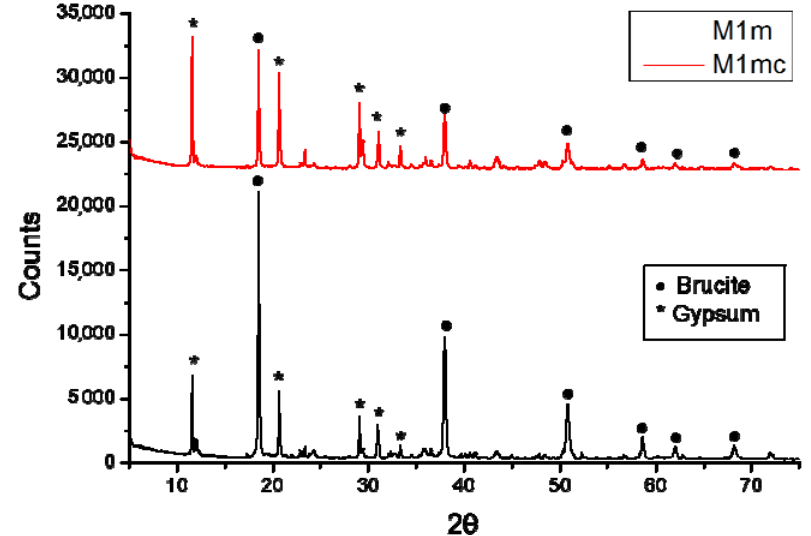
Figure 12. XRD overlay diffractograms of the coatings, M1m and M1mc, after the effect of acid spraying, with sulfuric acid solution (4 M) for 10 days (using daily the 17% of the respective reaction’s stoichiometry).